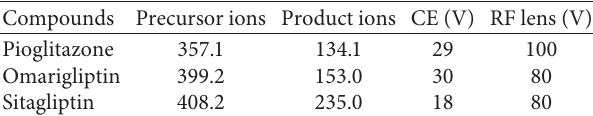
Table 2: Optimized parameters for the detection of pioglitazone, omarigliptin, and sitagliptin